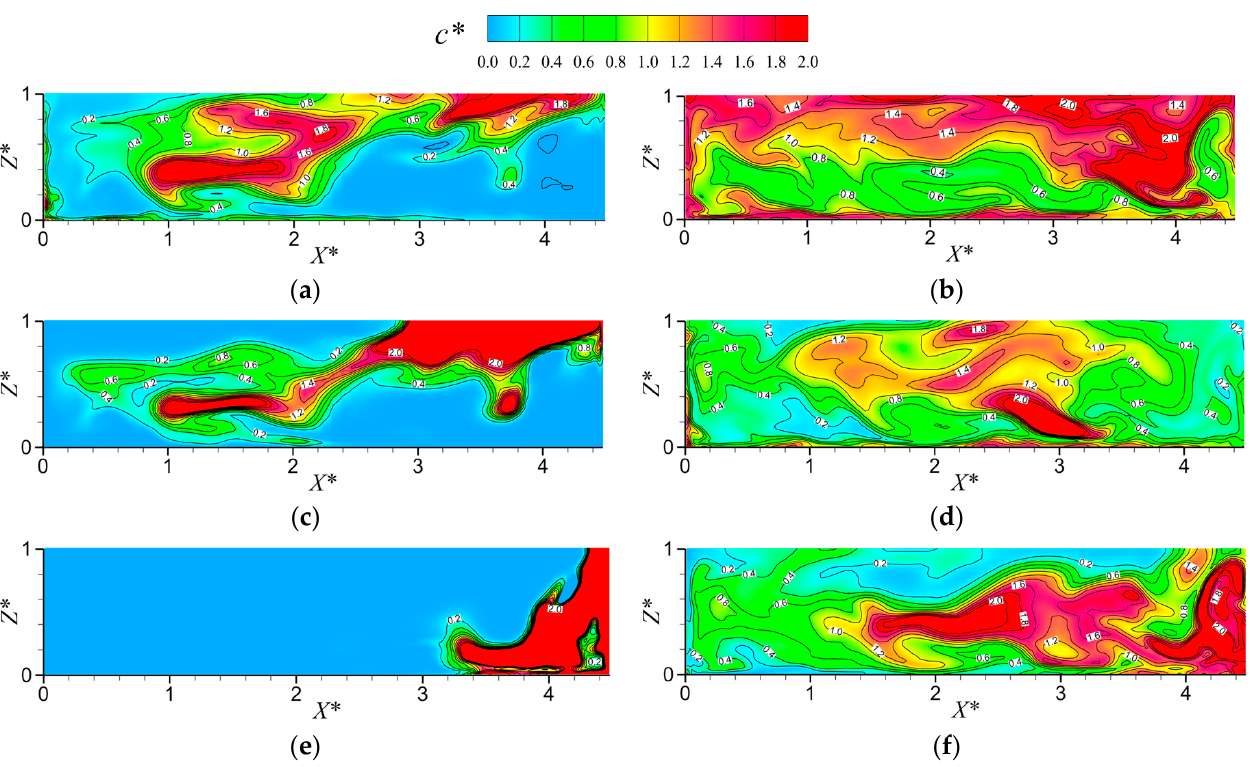
Figure 16. The normalized instantaneous concentration c* . (From left to right denotes from inner bank to outer bank). ( a ) Section #04 in Case S1; ( b ) Section #07 in Case S1; ( c ) Section #04 in Case S3; ( d ) Section #07 in Case S3; ( e ) Section #04 in Case S5; ( f ) and Section #07 in Case S5.